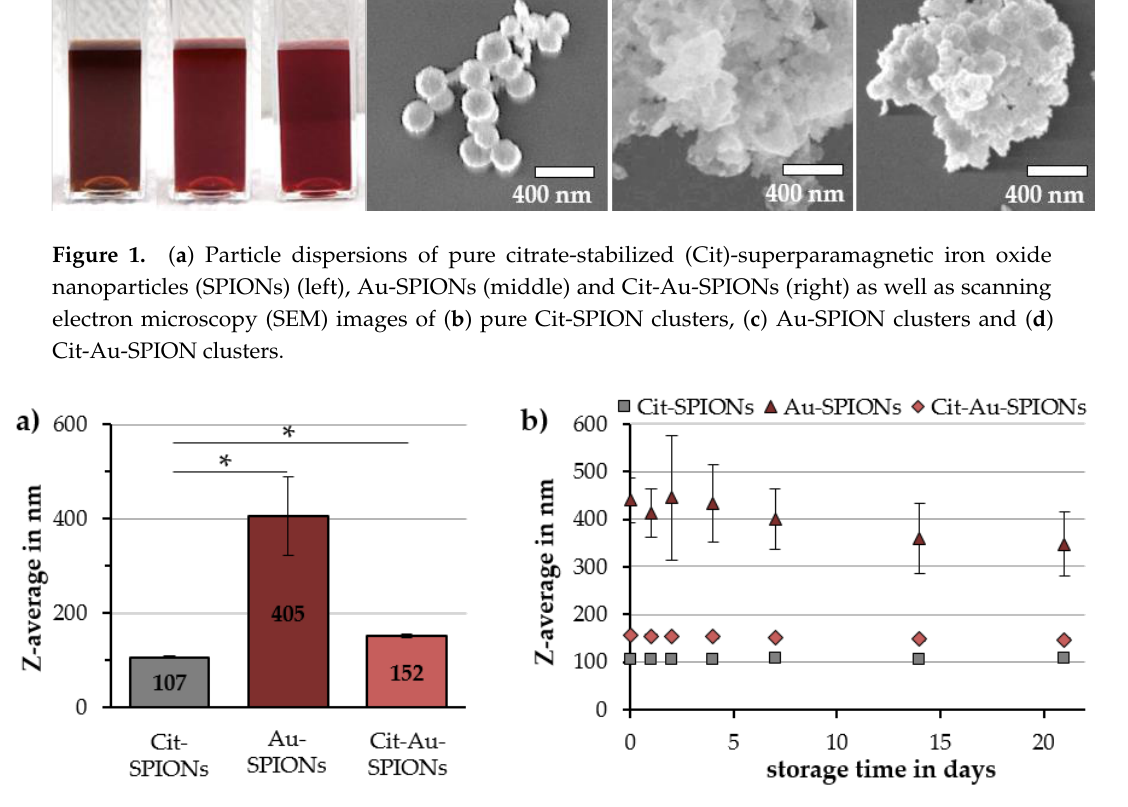
Figure 2 . ( a ) Mean Z-averages over 21 days for Cit-SPIONs, Au-SPIONs and Cit-Au-SPIONs; ( b ) Z-Averages of Cit-SPIONs, Au-SPIONs and Cit-Au-SPIONs during storage for different time points. Statistically significant changes are marked with * for p < 0.05.